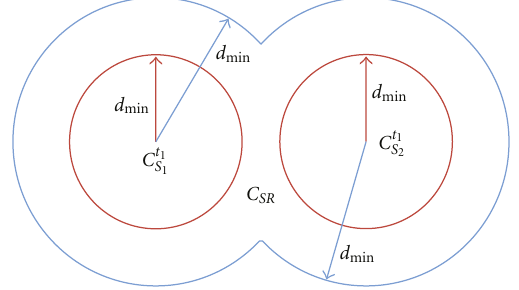
Figure 4: The minimum distances of C SR and C t 1